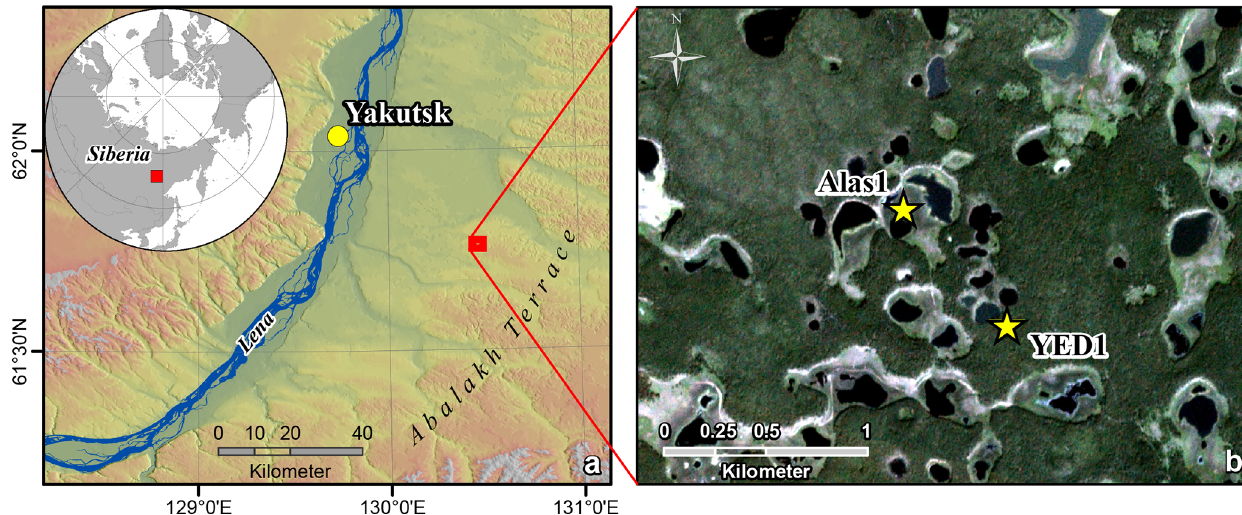
Figure 1. Study site overview: (a) location of the Yukechi alas study site in central Yakutia on the edge of the Abalakh Terrace (circumpolar digital elevation model, Santoro and Strozzi, 2012); (b) locations of the Alas1 and the YED1 coring sites within the Yukechi alas landscape (Planet Ortho Tile, acquisition date: 7 July 2018; Planet Team,